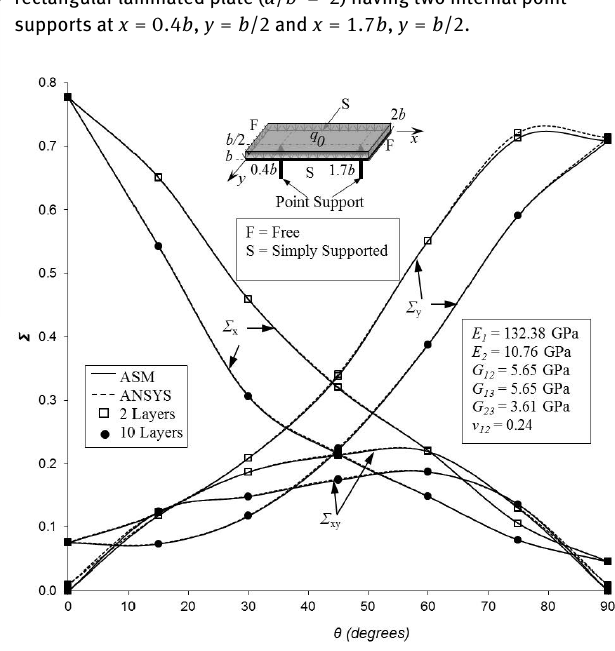
(︁ )︁ (︁ )︁ , b = a h 2 σ , versus ply 2 2 b 2 q